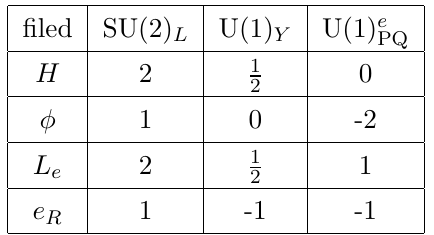
Table 1 . All particles with SU(2) L Peccei-Quinn-like symmetry. H and L e ( e R ) are SM Higgs and left-handed (right-handed) electron, while (cid:30) is the new light singlet complex scalar.